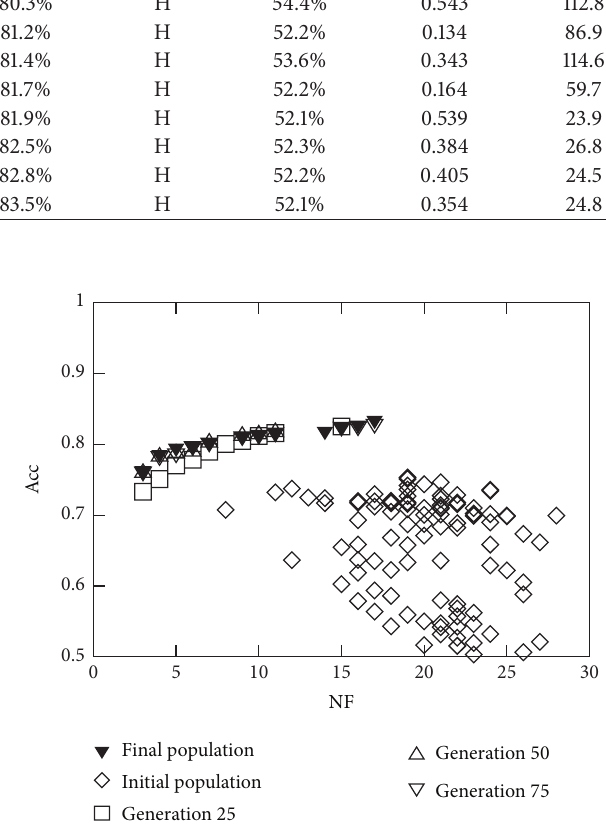
Figure 3: Run-a of Experiment 2 (initial population and nondomi- nated solutions of the final